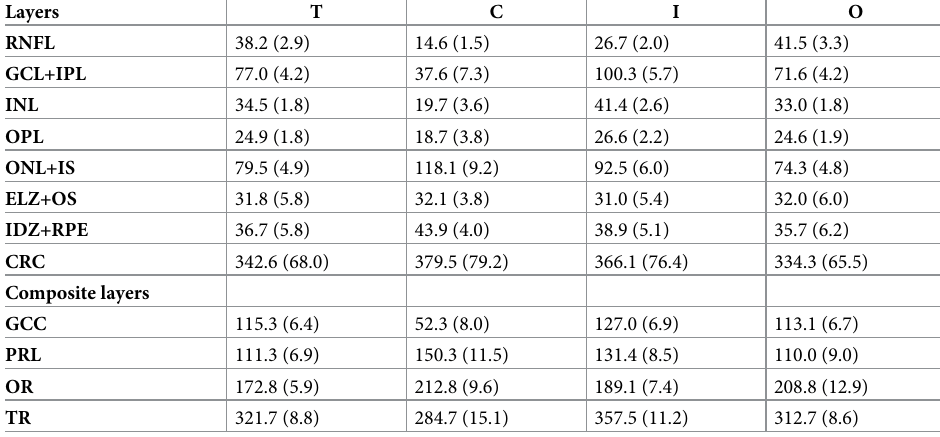
The data are shown as means (SD). For the abbreviations, see Fig